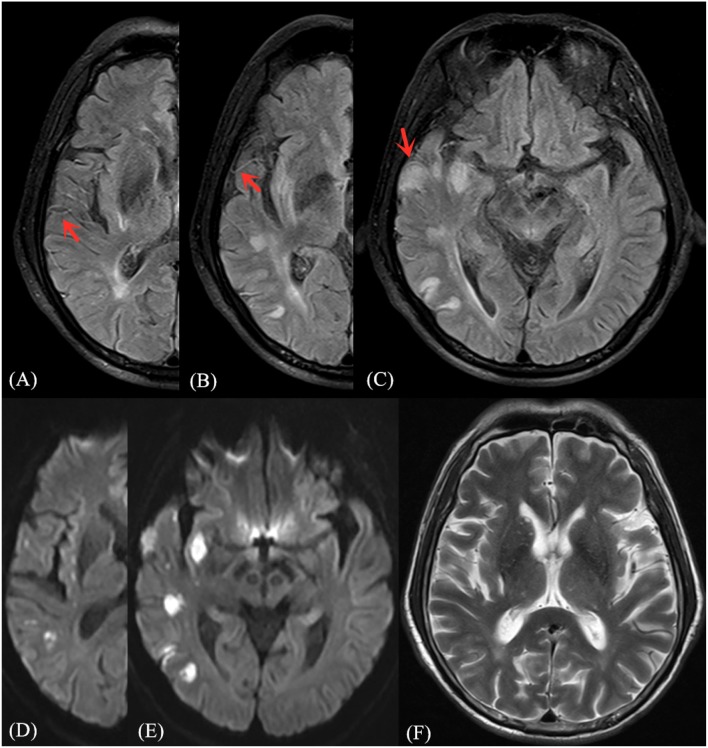
Illustrative case of FVH-DWI match. Magnetic resonance (MR) imaging of a 68-year-old man obtained 2 days after sudden onset of left limb paralysis and speech disorder. Partial prominent FVH on FLAIR (A–C) is more extensive within the boundaries of the DWI (D,E) high signal area, indicating an FVH-DWI match. Prominent FVH presents flow voids on the corresponding T2WI image (F).